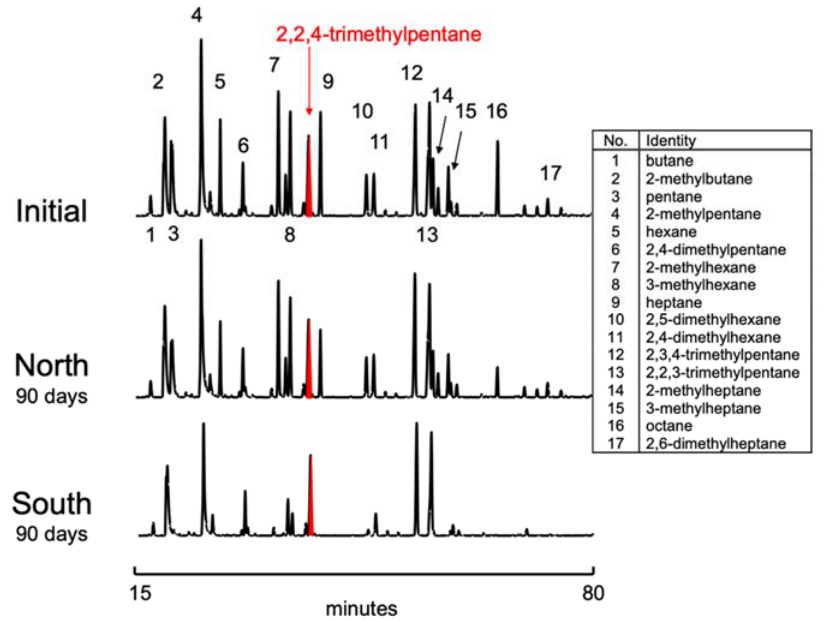
Figure 3. Purge-and-trap selected ion monitoring ( m / z = 43) chromatograms of C 4 to C 8 alkanes in the initial gasoline, and of gasoline exposed to water from the South and North Arms of the Great Salt Lake for 90 days of incubation. The chromatograms are normalized to 2,2,4-trimethylpentane ( iso -octane), shown in red, and the principal components are identified.